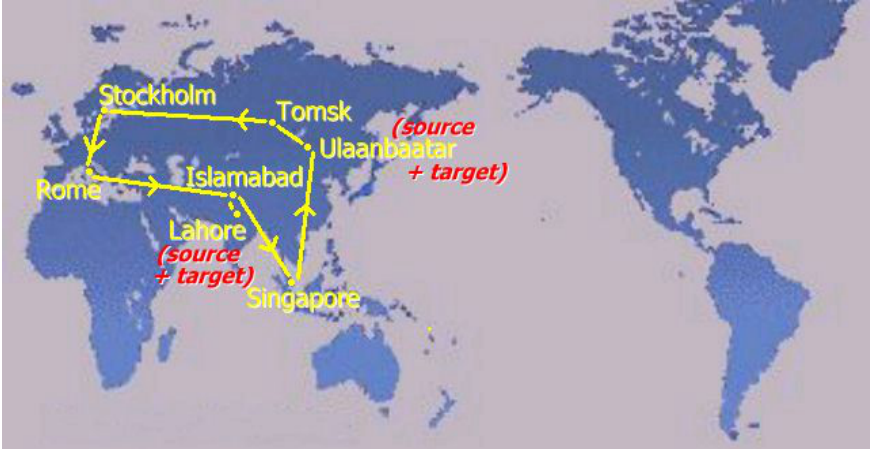
Figure 2. The routes between Lahore and Ulaanbaatar (outward via Islamabad and Singapore; return via Tomsk, Stockholm, Rome, and Islamabad)